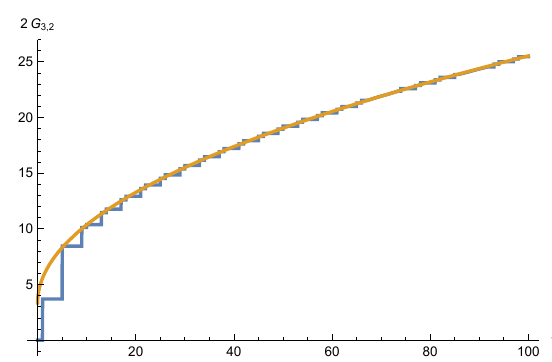
Figure 6 . Second moment of the weighted spectral density for primary operators of spin J = 2 in the 2d Ising model. We (cid:12)t the constant b 3 (cid:25) 3 : 35. The smooth curve is given by the r.h.s. of (6.12). It is plotted against the exact integrated weighted spectral density of the 2d Ising model.